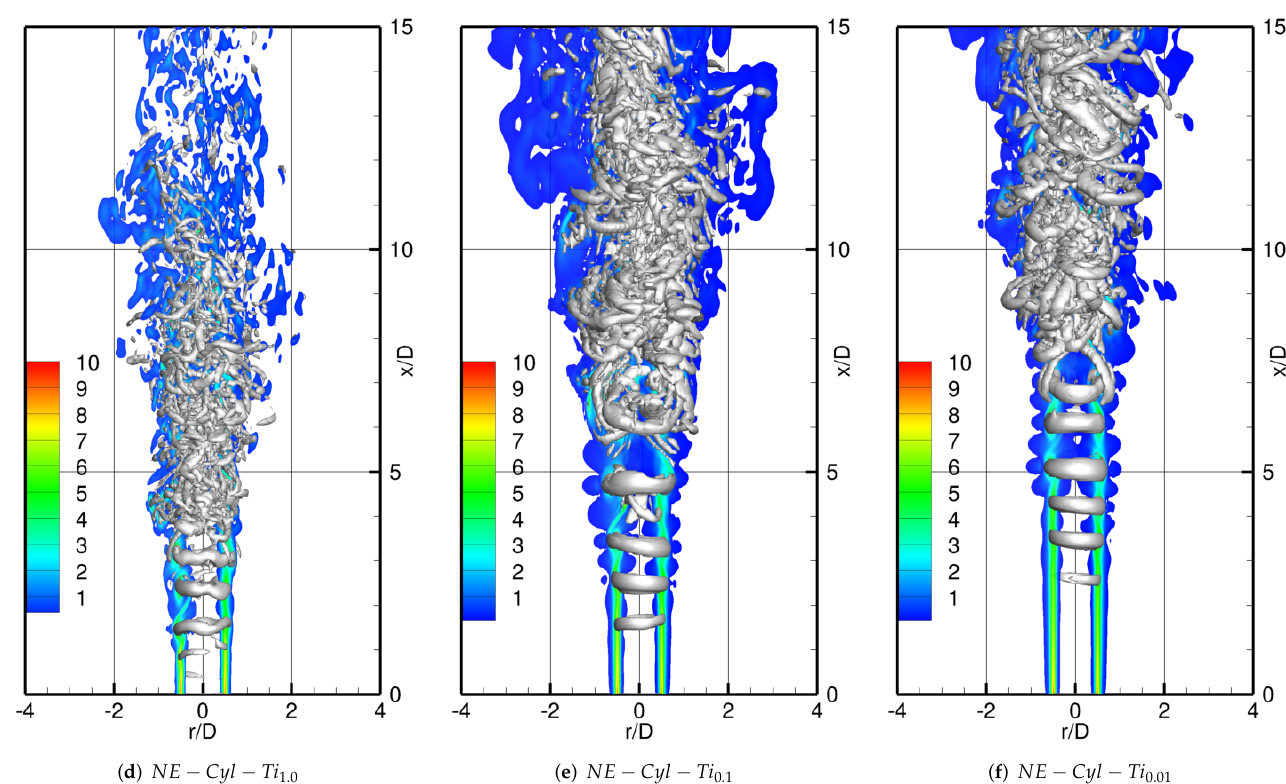
Figure 3. Contours of instantaneous values of the vorticity modulus | Ω | × D / U 0 in the central cross-section and isosurfaces of the Q-parameter ( Q = 1 ( U 0 / D ) 2 ) in the Cartesian and cylindrical coordinate systems obtained for Ti = 0.01%,0.1% and